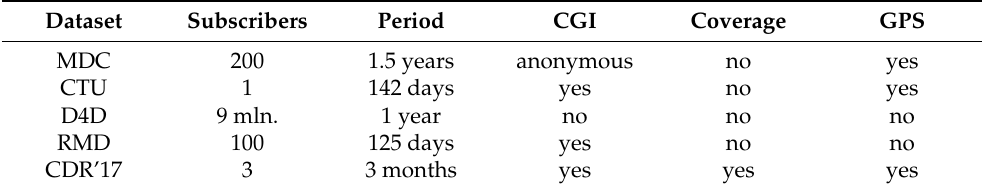
Table 1. Comparing the available datasets; important features are highlighted in separate columns: total number of unique subscribers; data collection period; recorded cell global identifiers (CGI); cellular coverage map; recorded GPS ground-truth